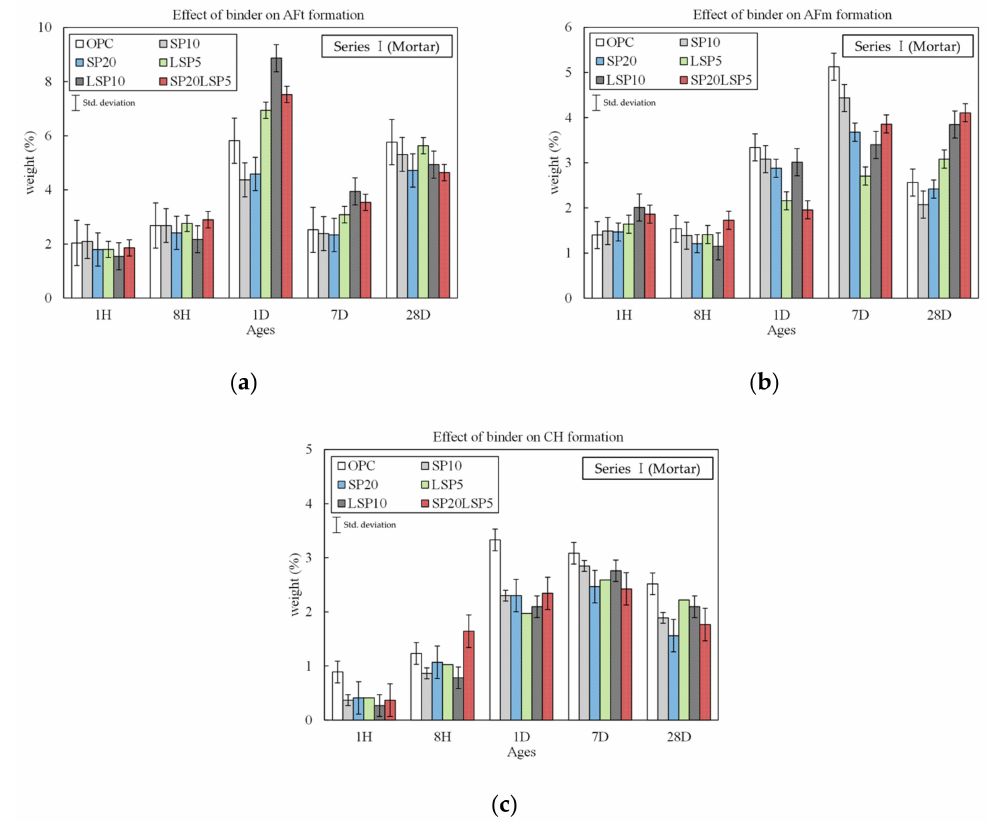
Figure 2. Amount of hydrate phases in each binder type: ( a ) Aft formation; ( b ) AFm formation; ( c ) CH